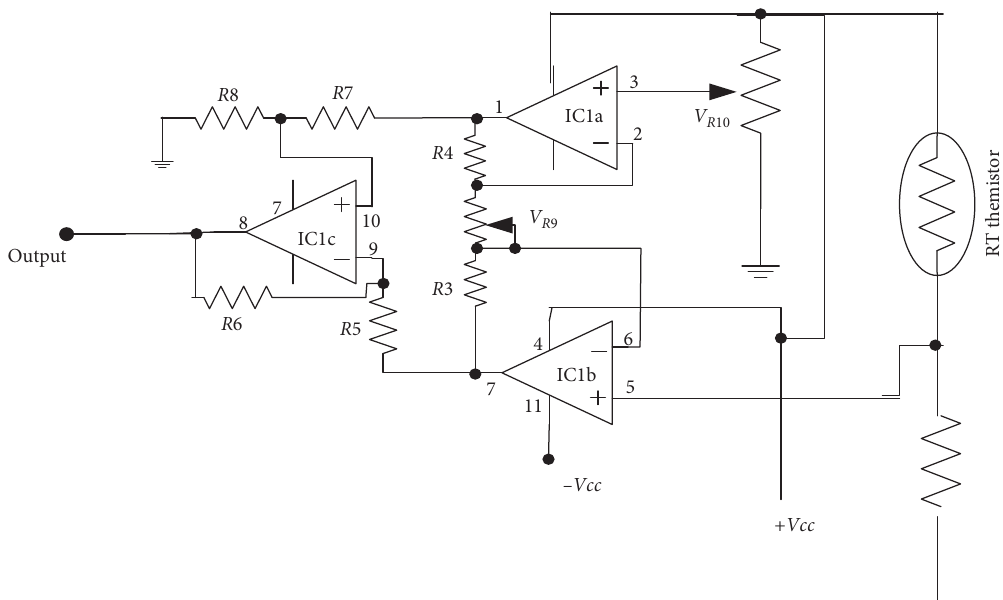
Figure 4: The circuit diagram of the temperature sensing and